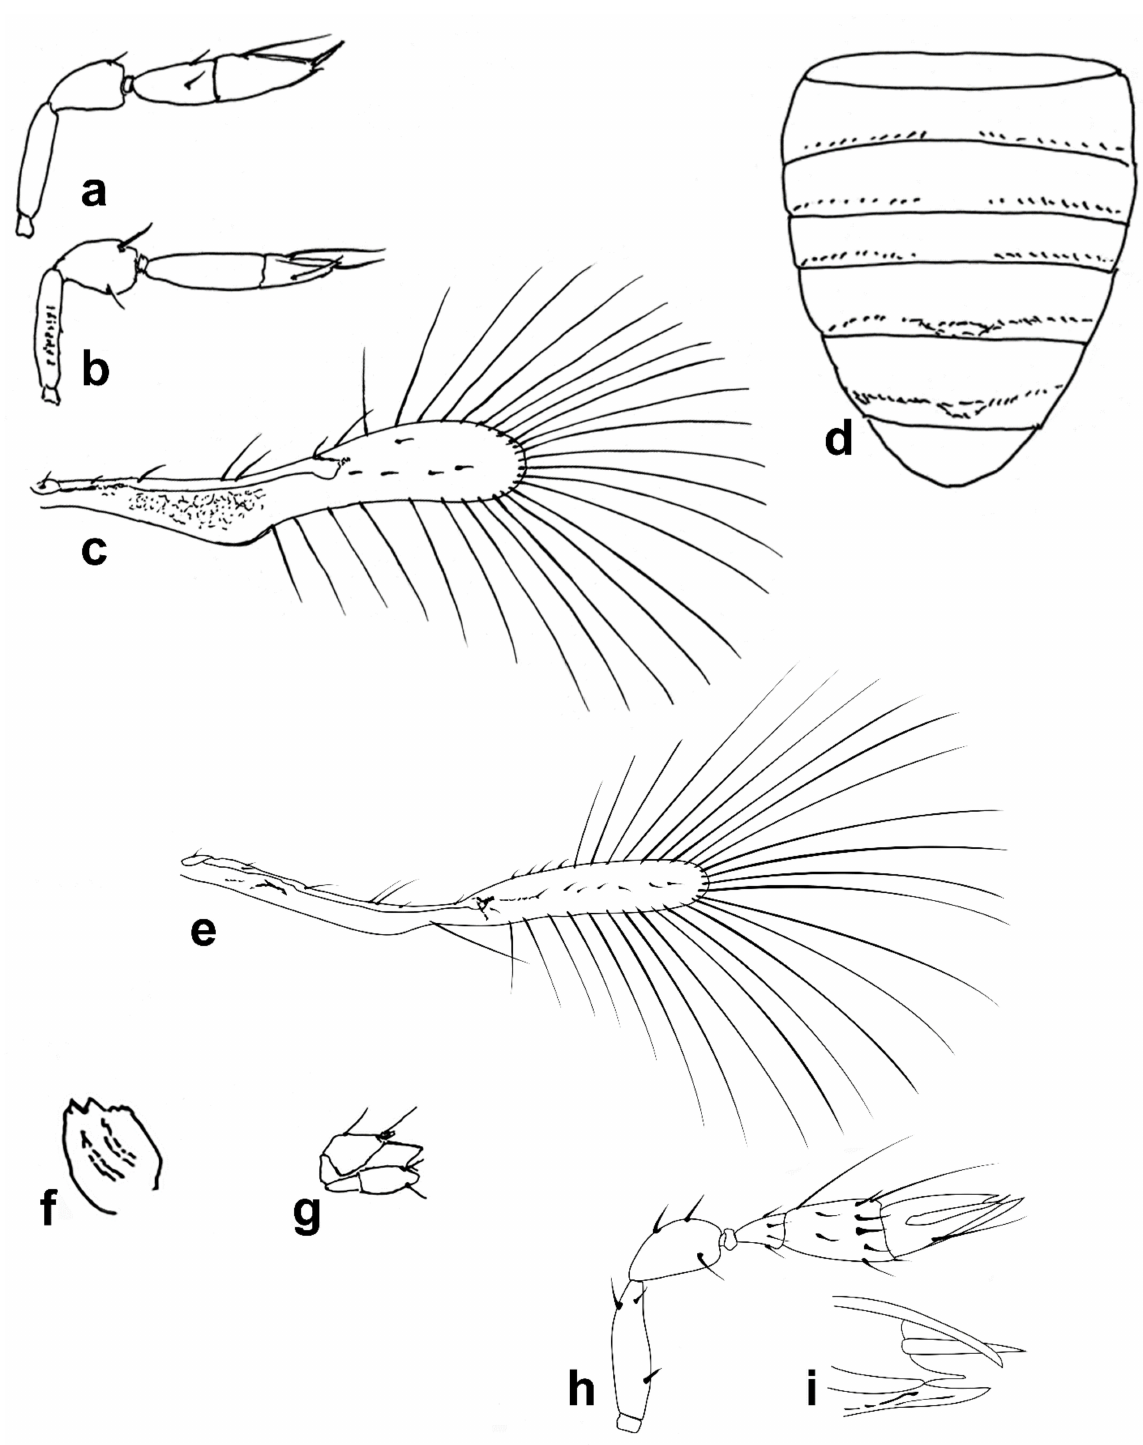
Figure 6. Line drawings of Megaphragma species: ( a ) M. macrostigmum , female antenna (Paratype); ( b ) M. macrostigmum , male antenna (Holotype); ( c ) M. macrostigmum , female fore wing (Paratype); ( d ) M. macrostigmum , male dorsal metasoma (Holotype); ( e ) M. mymaripenne , female fore wing (Holotype); ( f ) M. mymaripenne , mandible (Holotype); ( g ) M. mymaripenne , maxillary palp (Holotype); ( h ) M. mymaripenne , female antenna (Holotype); ( i ) M. mymaripenne , female antenna (detail of apex)